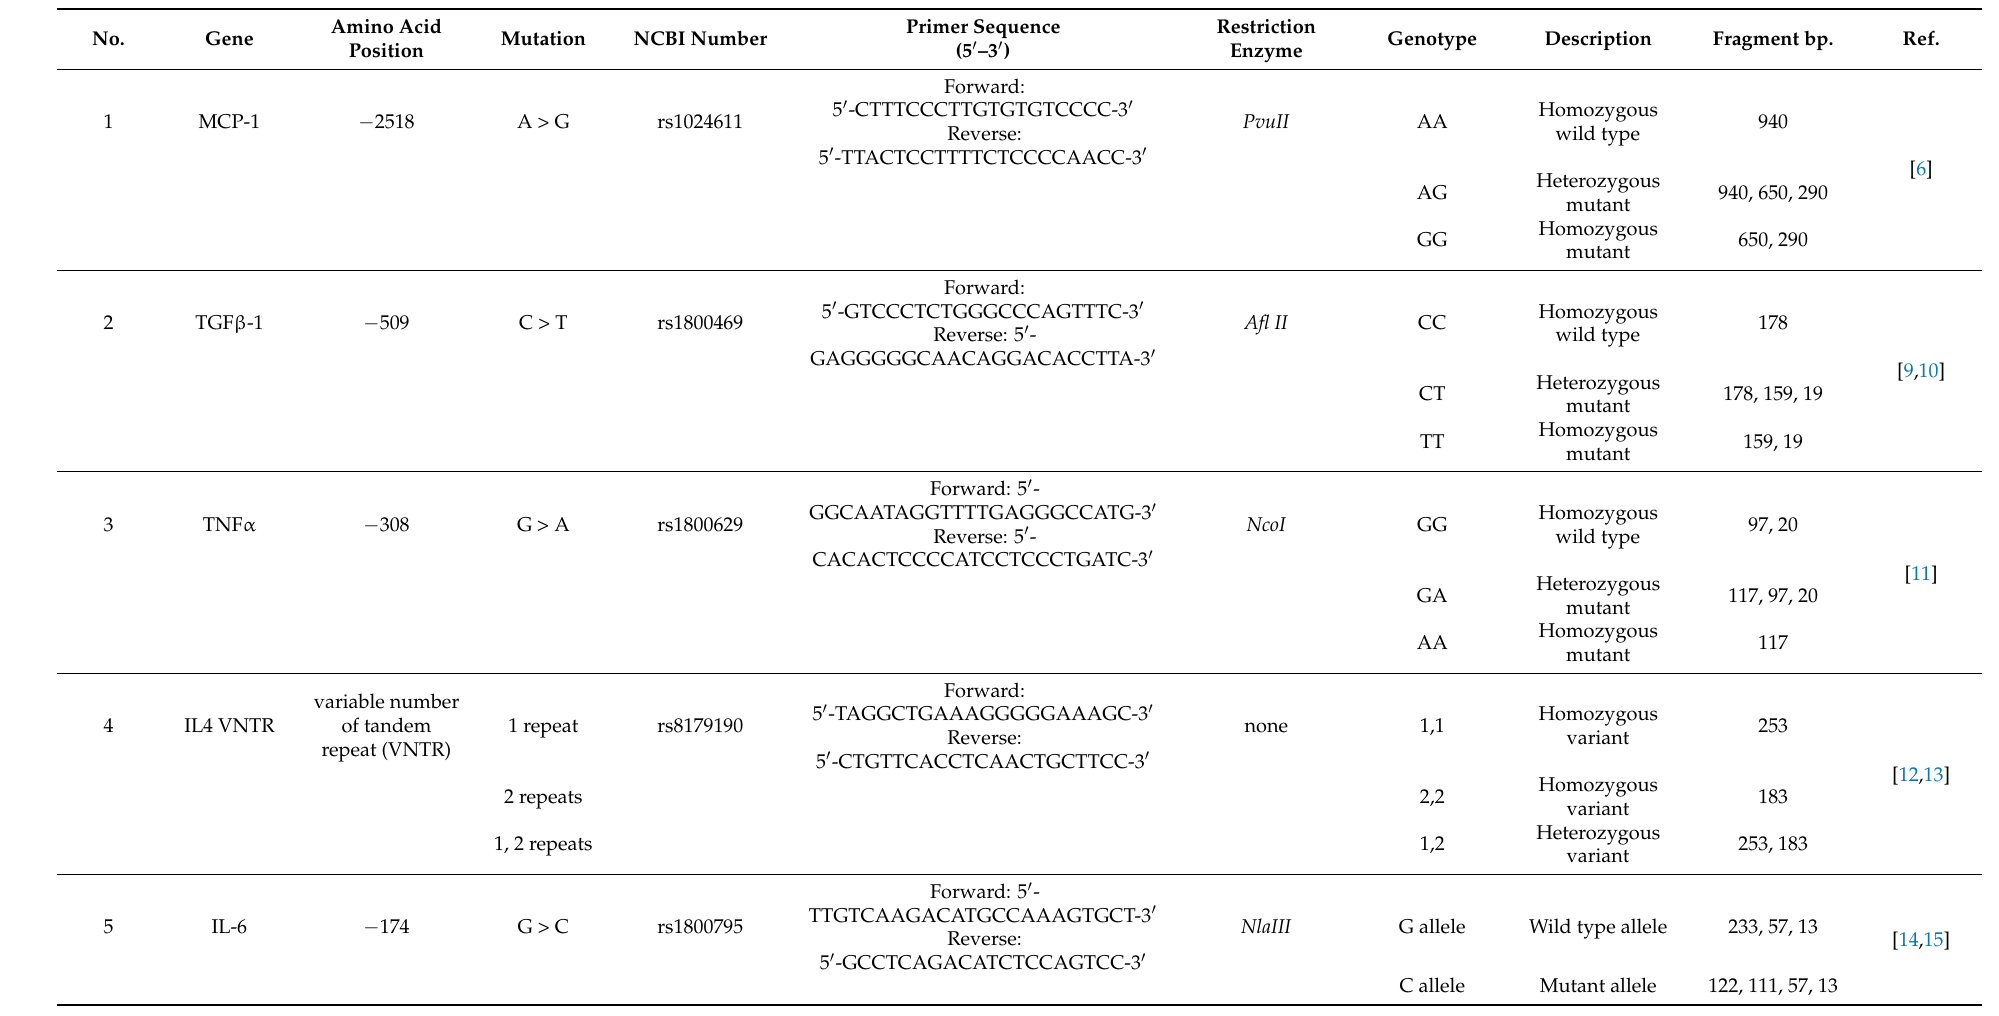
Table 1. The primers and analysis conditions of nine host genes involved in immune response and malaria parasite binding (amino acid/nucleotide positions with mutation and genetic analysis) under